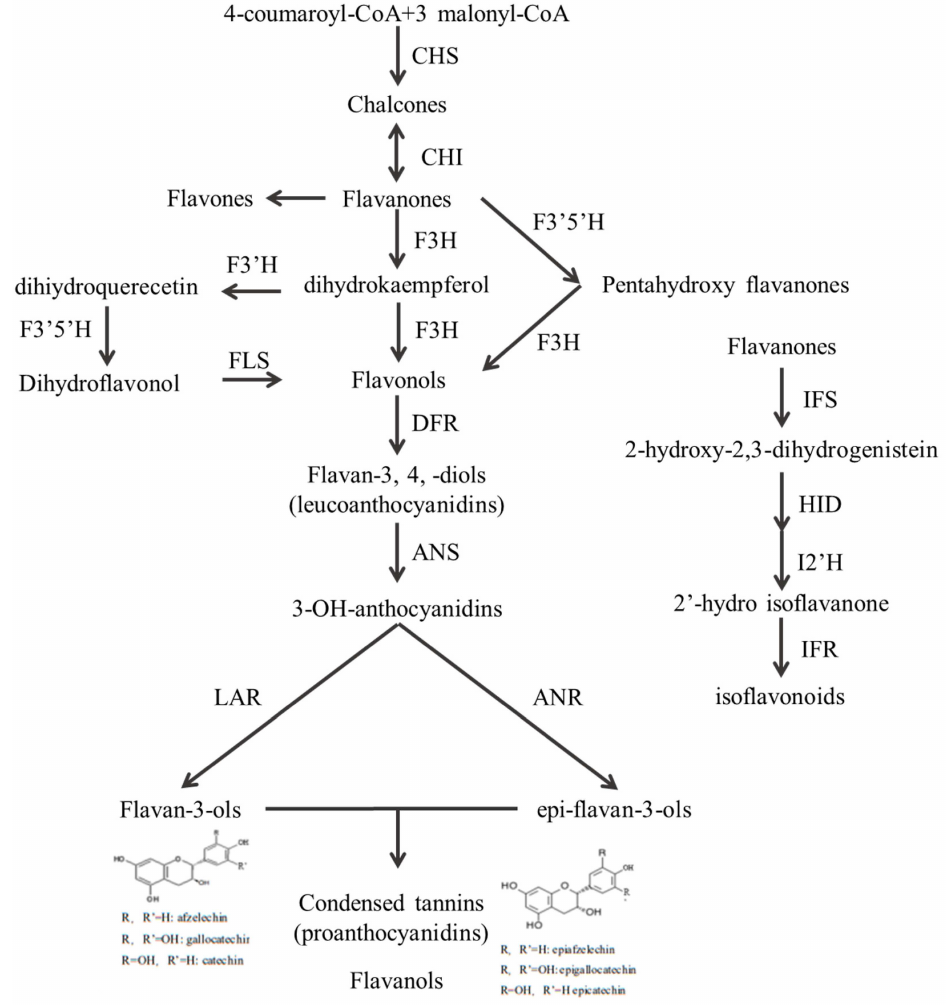
Figure 1. Flavonoid biosynthesis